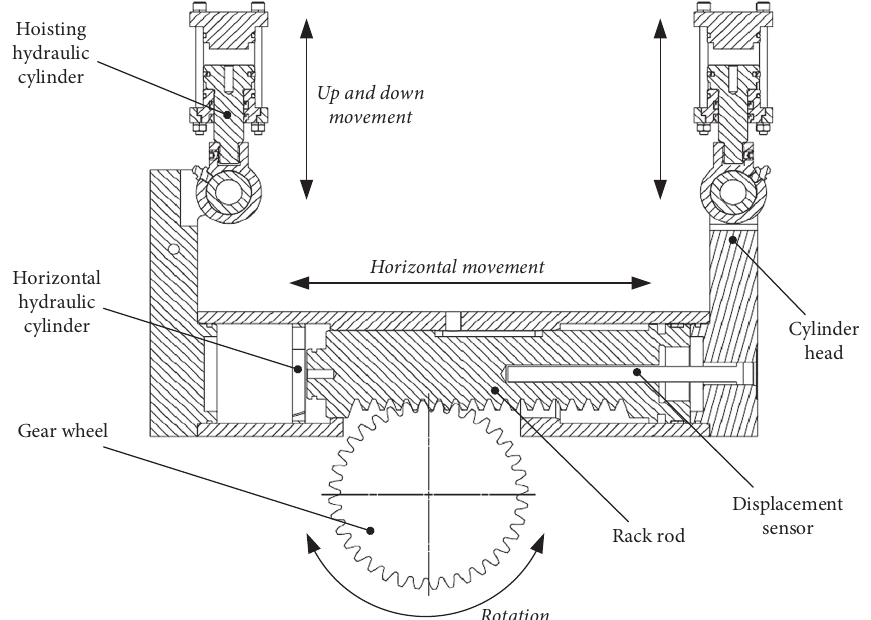
Figure 8: The structure diagram of horizontal movement mechanism.